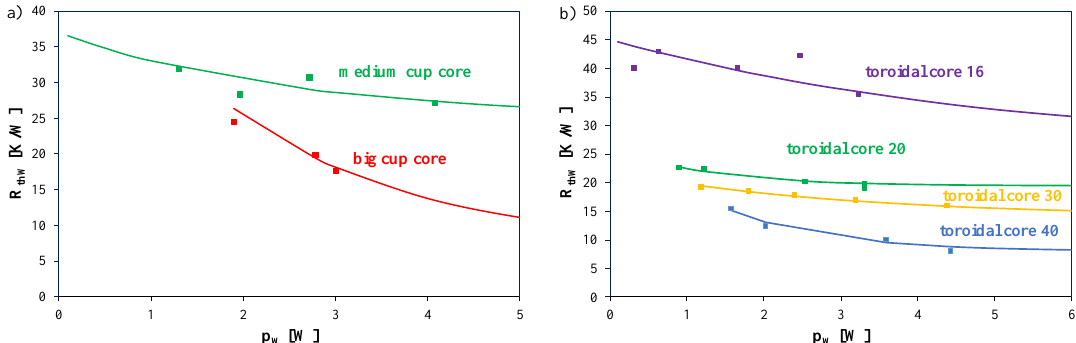
Figure 14. Measured and calculated dependences of thermal resistance R thW of inductors winding with ( a ) cup cores and ( b ) toroidal core on dissipated power in the winding.